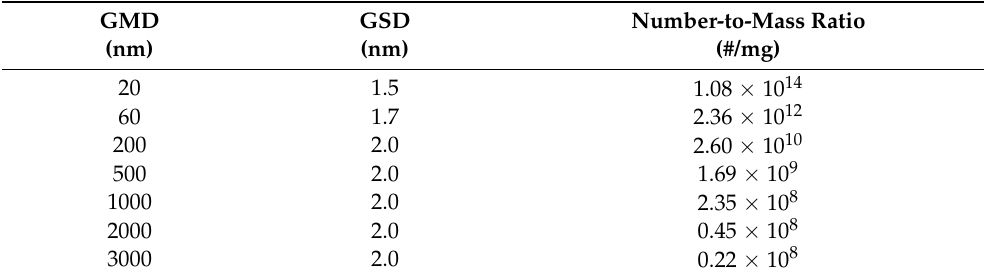
Table 3. Relationship between number and mass for various size distributions, assuming a density of unity and a setup with a cut-off at 10 µ